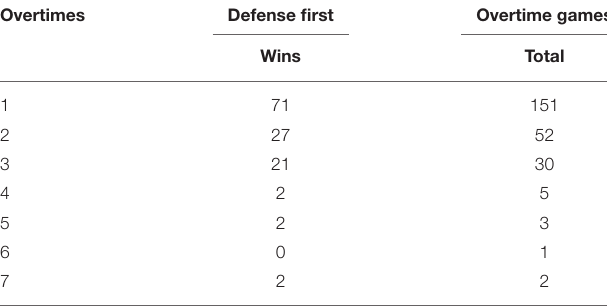
TABLE 3 | Results by number of overtimes.